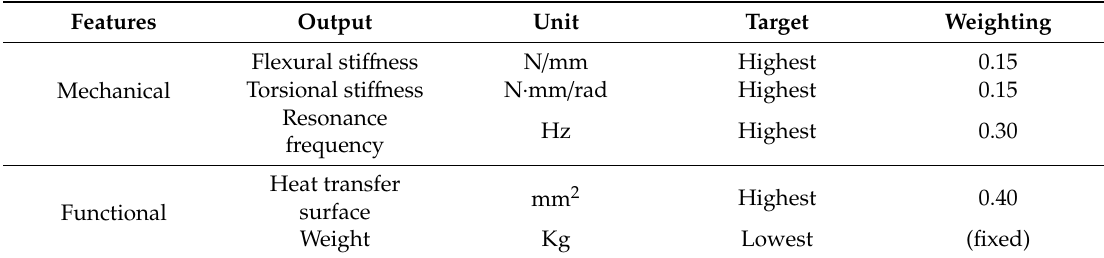
Table 3. Optimization objectives and related weighting coe ffi